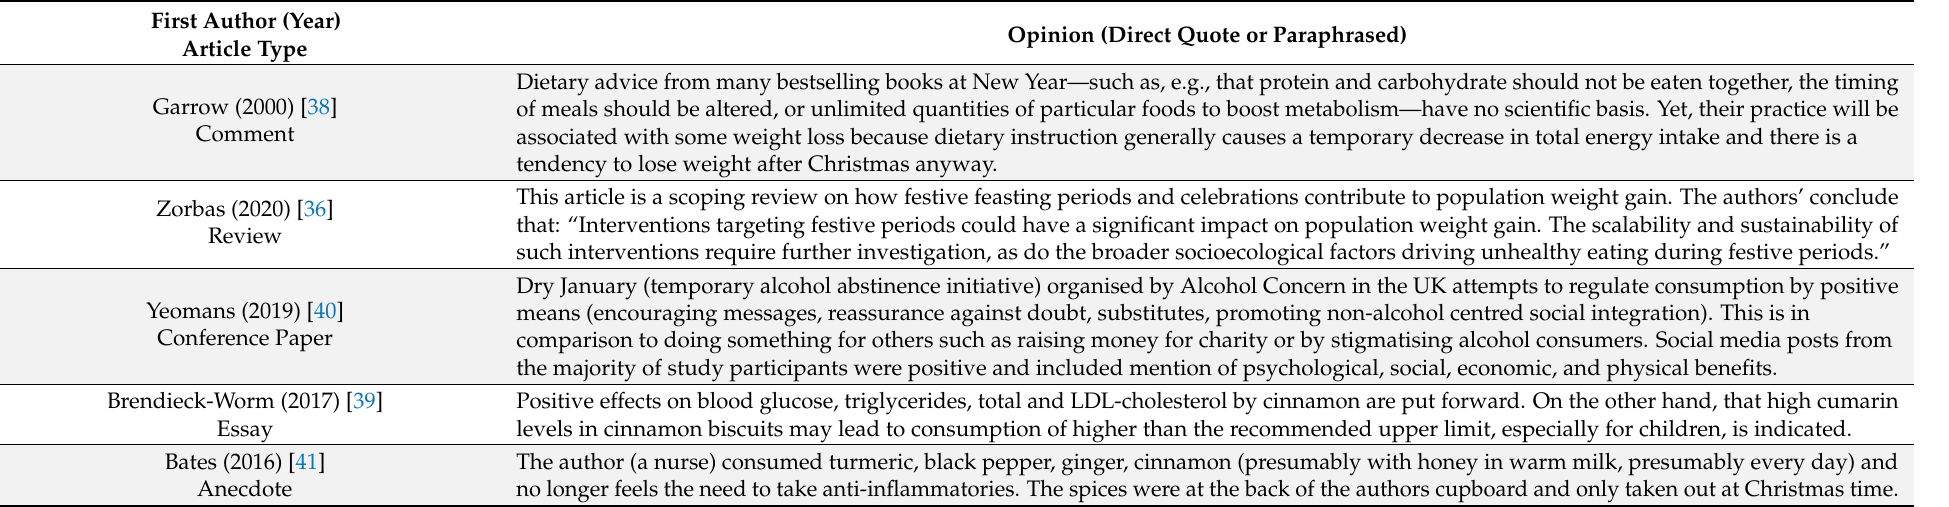
Table 3. Published Opinion Concerning Diet at Christmas and New